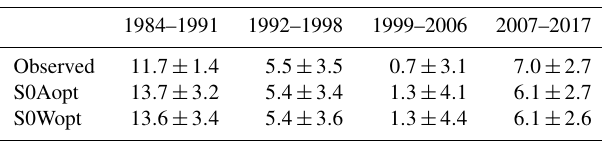
Table 3. Comparisons of simulated methane growth rates (annual mean ± standard deviation) with observed methane growth rates (ppbyr − 1